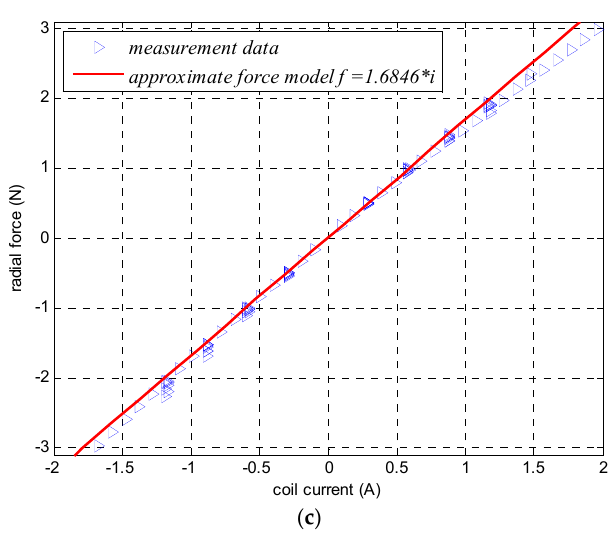
Figure 5. The magnetic force of a hybrid magnetic unit ( N = 350): ( a ) s = 1.5 mm; ( b ) s = 2.0 mm; and ( c ) s = 2.5 mm.